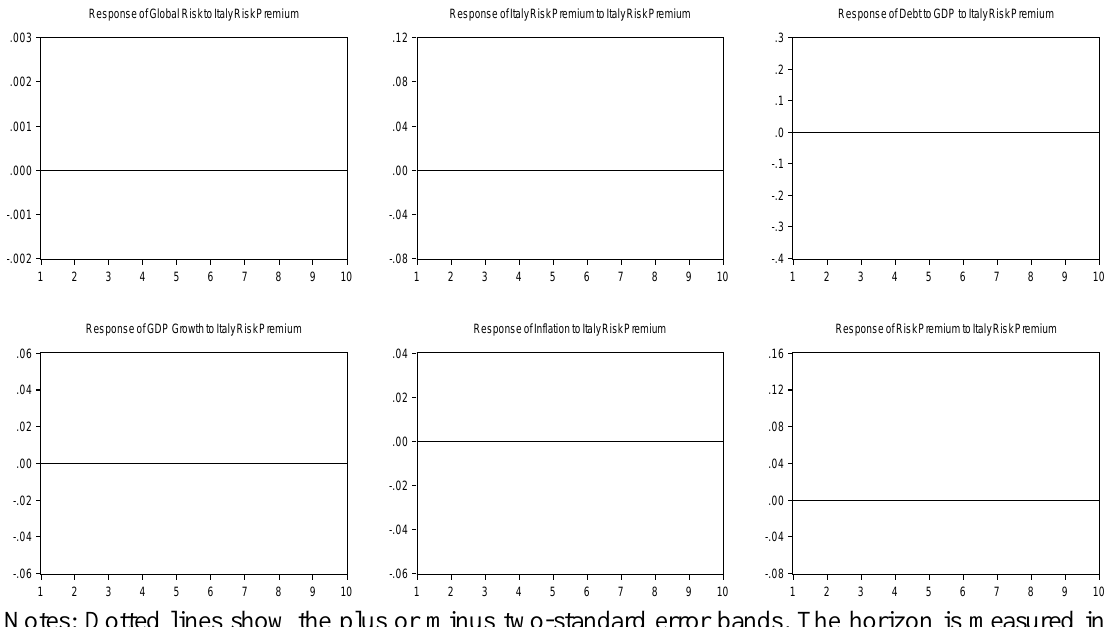
Notes: Dotted lines show the plus or minus two-standard error bands. The horizon is measured in quarters. See the notes to previous figures for additional details. Figure 7. Pre-crisis response of EMU countries to a shock to the German risk premium: 2001–2007.